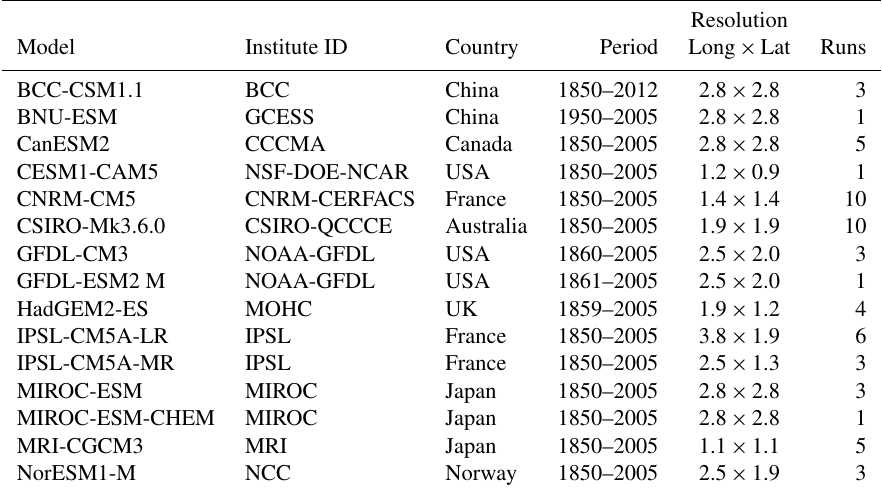
Table 1. Overview of GCMs used